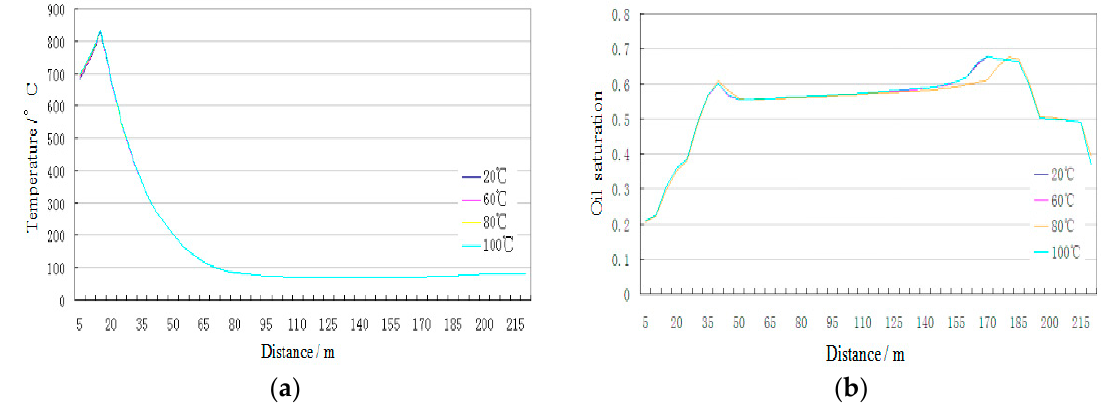
Figure 7. The temperature change of the firing front and oil saturation change under di ff erent air injection temperatures. ( a ) Temperature change of the firing front; ( b ) oil saturation change.